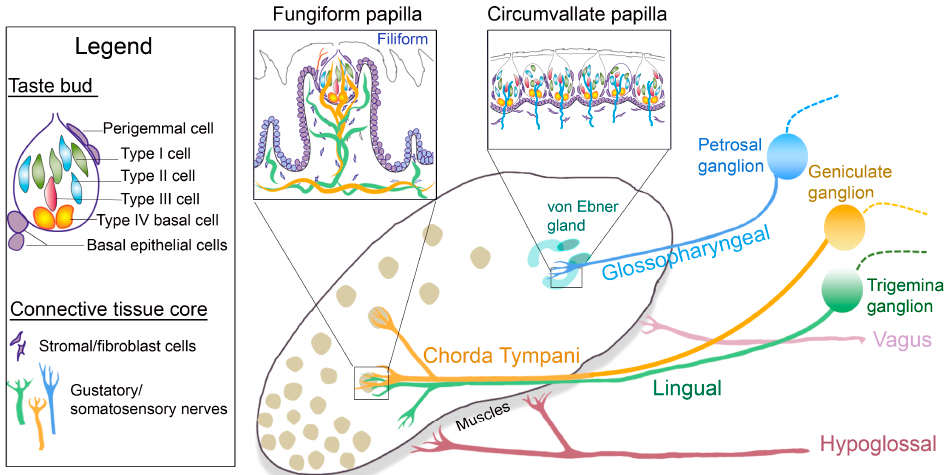
Figure 1. Anterior and posterior tongue papillae and nerves: Diagram of the tongue dorsum illustrating the taste organs, multiple fungiform (rounded) and single circumvallate (U-shaped) papillae on the anterior and posterior tongue, respectively. Minor salivary von Ebner glands, associated with circumvallate papillae, are labelled in the posterior tongue. The gustatory nerves, chorda tympani (yellow) and glossopharyngeal (blue), project from the corresponding sensory ganglia, geniculate and petrosal, respectively, to the anterior and posterior papilla taste buds. The somatosensory lingual nerve (green) fibers derive from the trigeminal ganglion, enter the anterior tongue together with the chorda tympani, and are within the connective tissue core of the Fungiform and non-gustatory Filiform papillae. The central projections of these nerves from the ganglia are represented in dashed lines. Hypoglossal and vagus motor fibers innervate the extrinsic and intrinsic tongue muscles and the posterior palatoglossus muscles. The boxed diagrams are as follows: The fungiform papilla, surrounded by non-taste filiform papillae, includes a single apical taste bud and a broad connective tissue core with stromal cells and innervation. The circumvallate papilla has numerous taste buds aligned next to each other in the epithelium with innervation and stromal cells in the connective tissues. The legend includes taste bud cell types (Type I, II, and III), taste bud progenitors (Type IV basal cells, perigemmal cells, and basal epithelial cells), and elements of the connective tissue core.